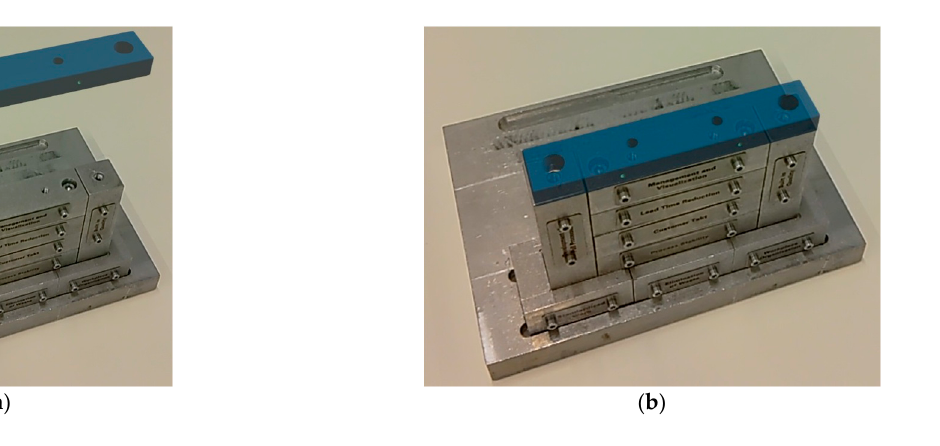
Figure 8. Snapshot of the UI-Panel taken from the HoloLens.